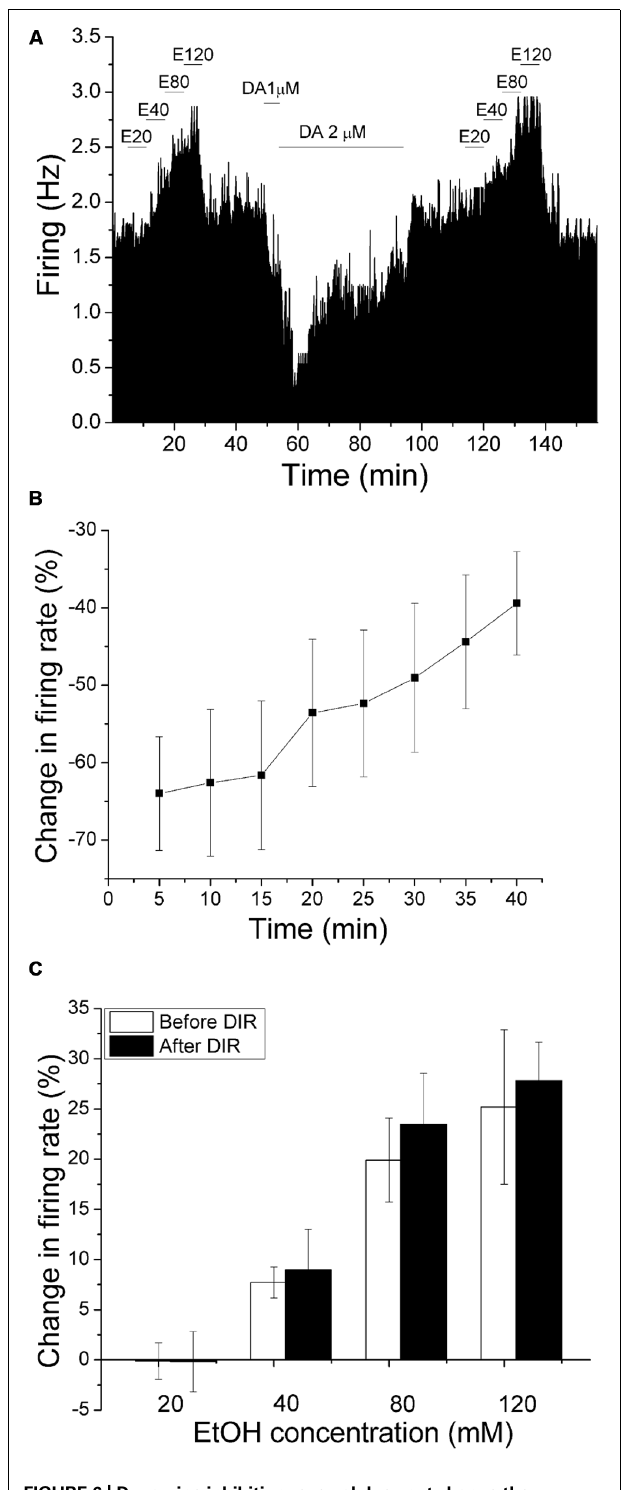
FIGURE 6 | Dopamine inhibition reversal does not change the excitatory effect of ethanol. (A) Mean ratemeter graph of the effects of ethanol application before and after dopamine inhibition reversal.Vertical bars indicate the firing rate over 5 s intervals. Horizontal bars indicate the duration of drug application (concentrations indicated above bar). Four